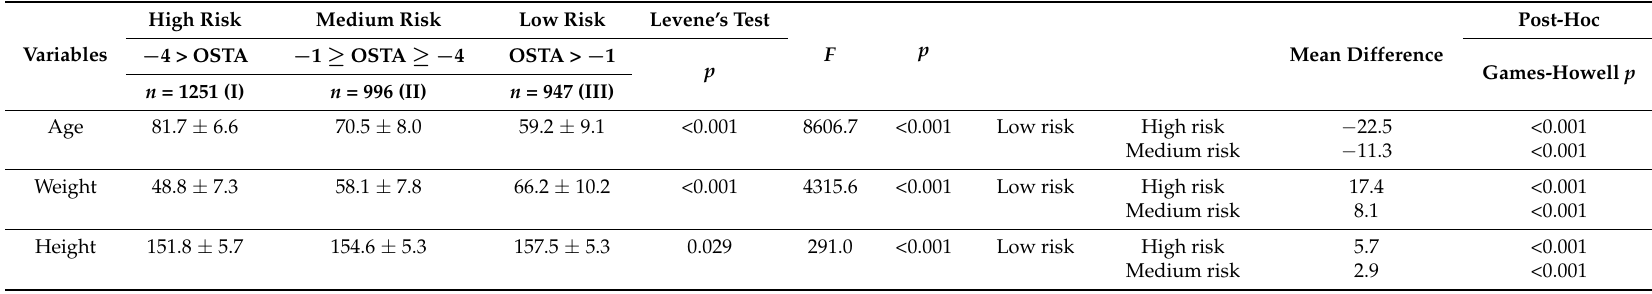
Table 5. Demographics of continuous variables in high-risk (OSTA < − 4), medium-risk ( − 1 ≥ OSTA ≥ − 4), and low-risk (OSTA > − 1) patients in fall accidents.